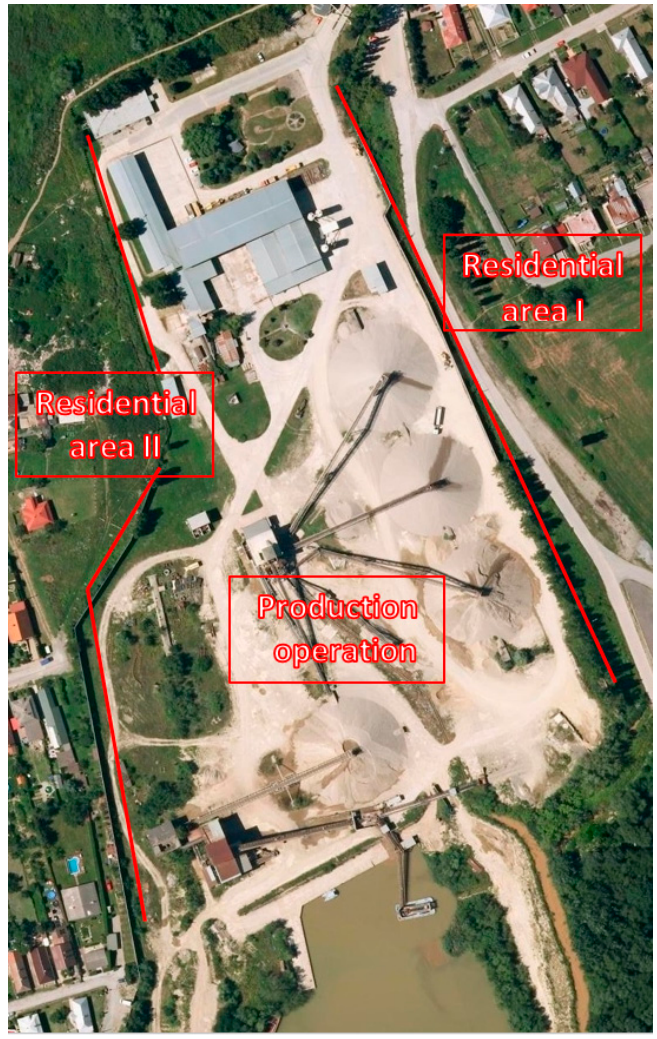
Figure 2. Production operation and residential areas.